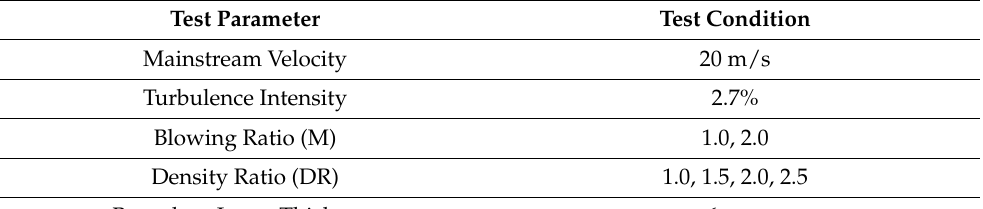
Table 1. Experimental conditions.